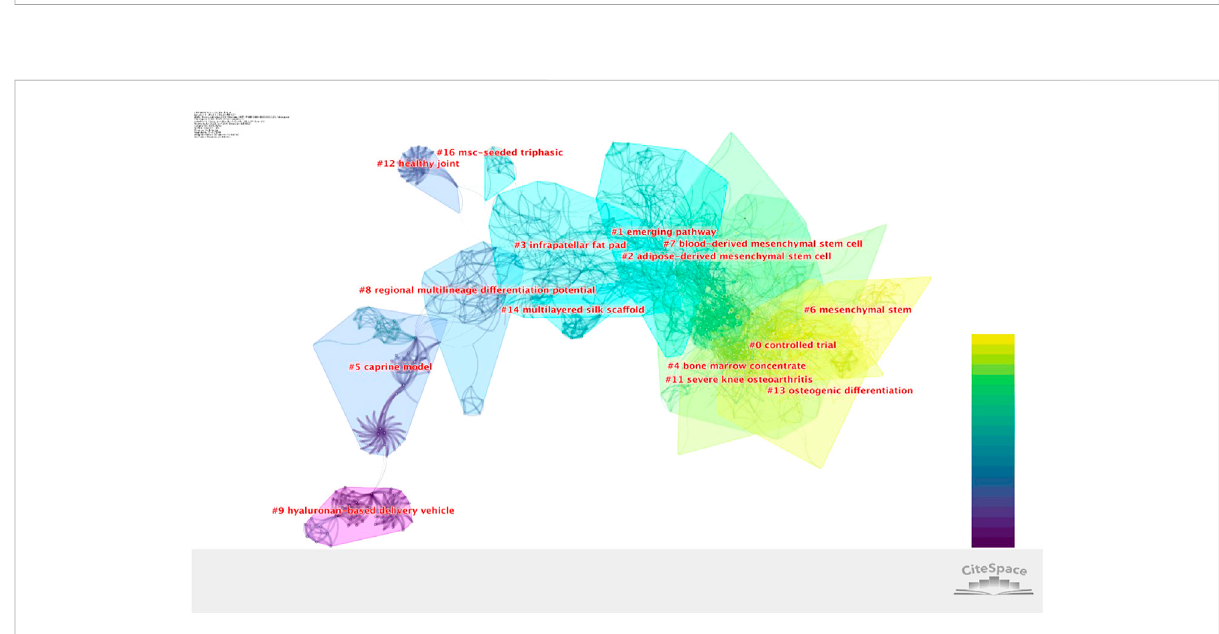
FIGURE 9 Analysis of co-cited reference clustering on stem cell therapy for KOA research. The color indicates the publication year. Vertical descending order indicates cluster size. The thickness of the line indicates the strength of the link.